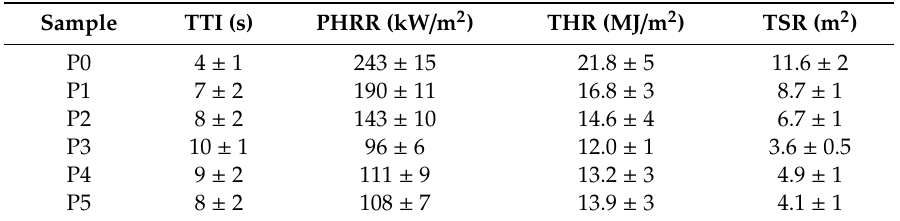
Table 4. Flame-retardant RPUF cone calorimetric analysis